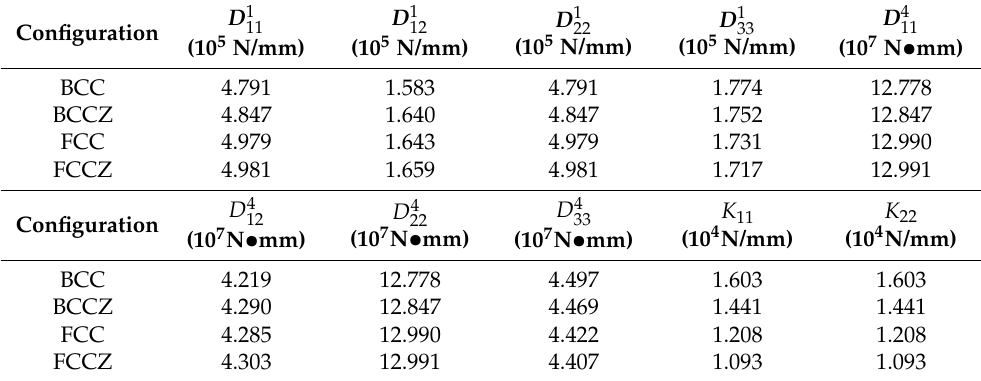
Table 8. Equivalent stiffness coefficients of different lattice cells.